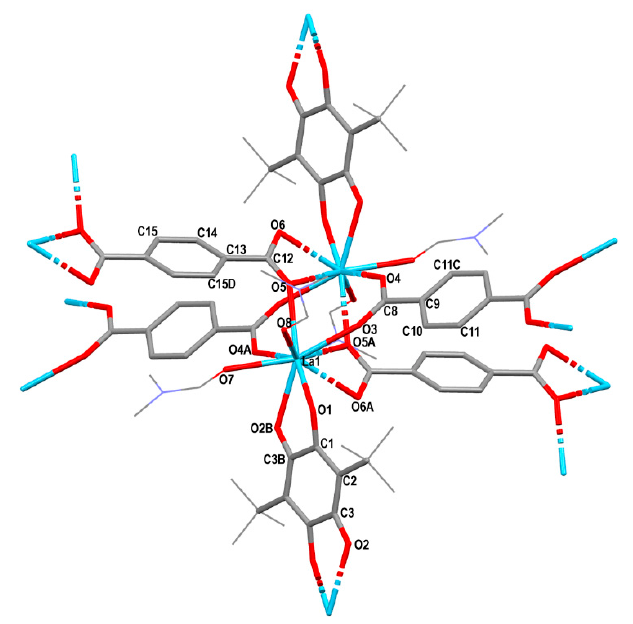
Figure 1. The molecular structure of the binuclear unit in 1 . Color code: La, light blue; C, gray; Cl, green; O, red; N, violet.